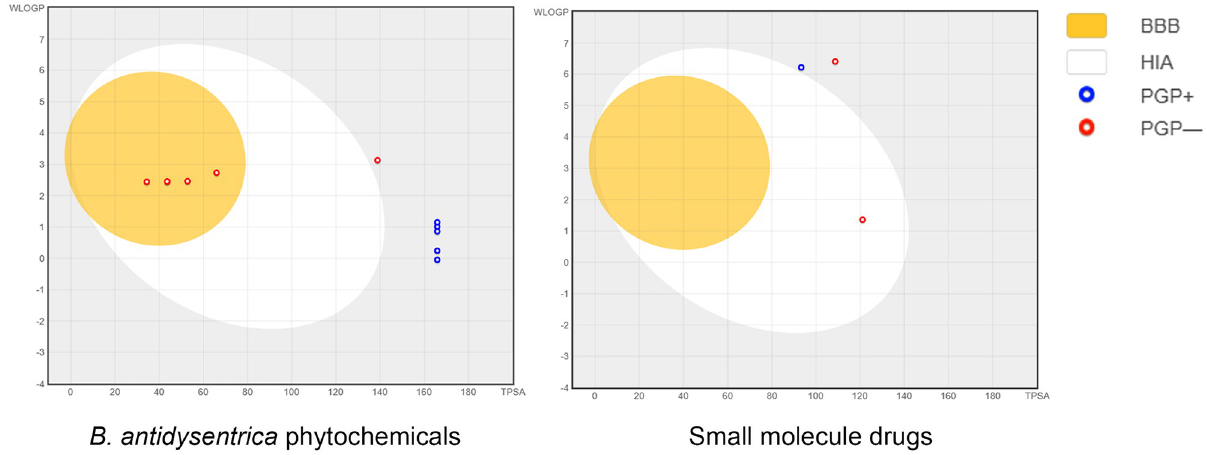
The phytochemicals exhibited acceptable gastrointestinal absorption which is an important property of a drug that is intended for mass treatment. In addition, phytochemicals 1-methox- ycanthin-6-one, 2-methoxycanthin-6-one, beta-carboline-1-propionic acid and Canthin- 6-one can cross the blood-brain barrier. The remaining compounds do not cross blood-brain barrier similar to that of small molecule approved drugs. The Brain Or Intestine EstimateD (BOILED-Egg) model prediction of GIA and BBB permeation for small molecule drugs and B . antidysentrica phytochemicals is presented in Fig 8. The compounds 2-methoxycanthin-6-one